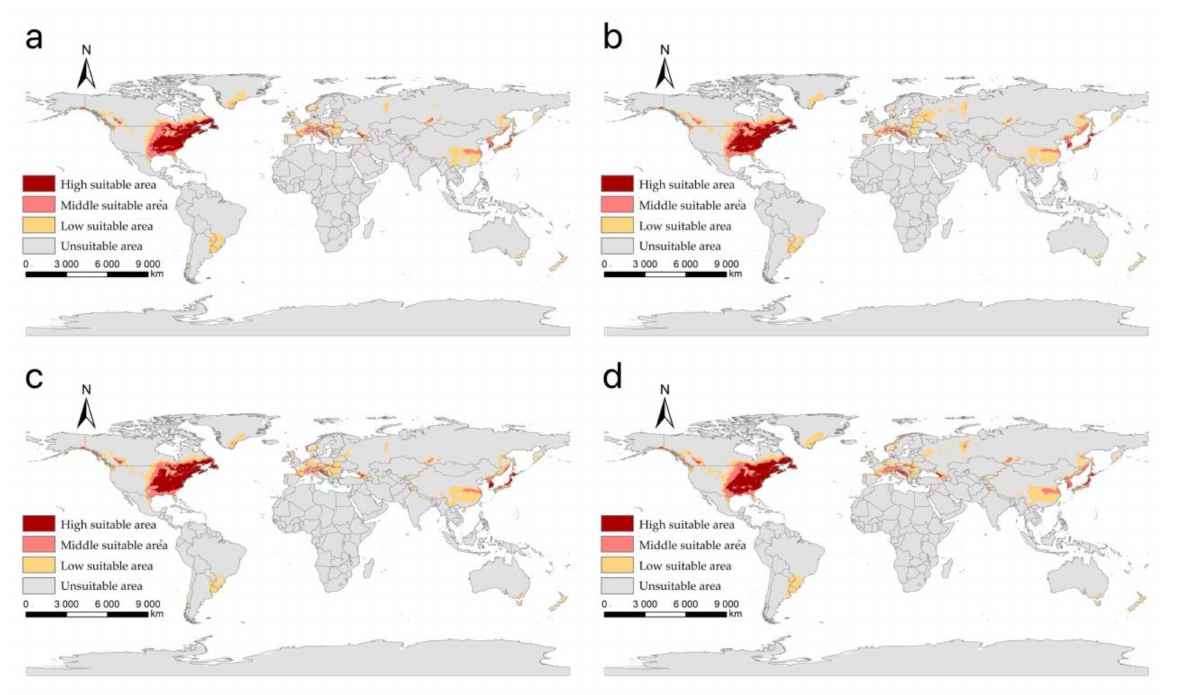
Figure 4. The suitable areas of I. scapularis around the world under shared socioeconomic pathway 1–2.6 (sustainability and radiative forcing of 2.6 W/m 2 to 2100) during different periods of the 21st century: ( a ) 2021–2040; ( b ) 2041–2060; ( c ) 2061–2080; ( d ) 2081–2100.